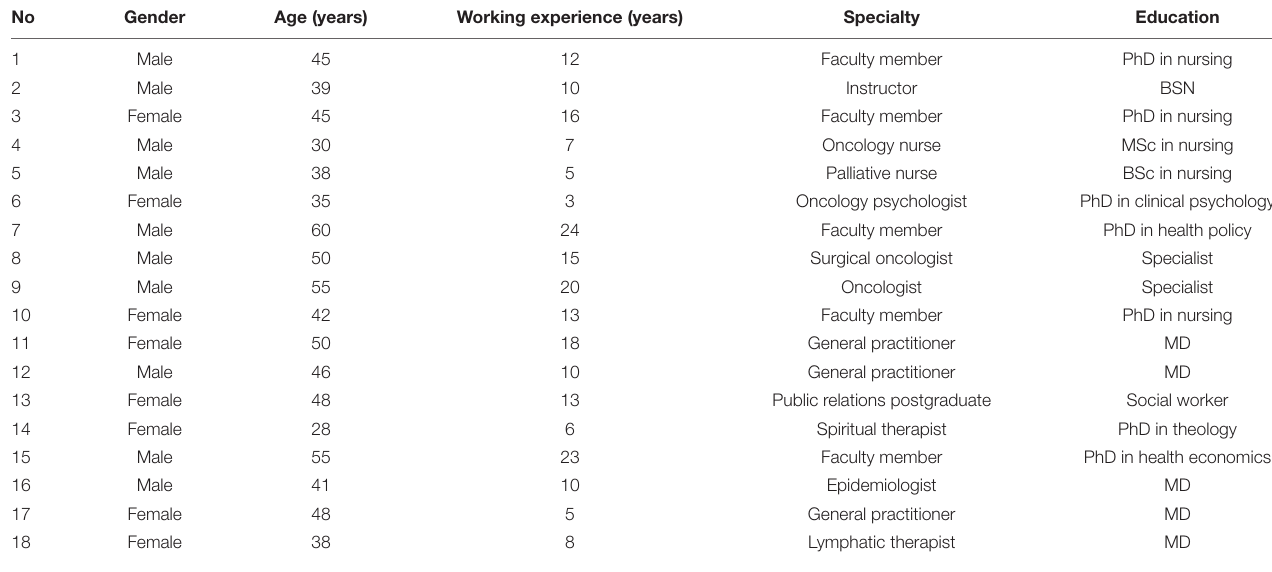
TABLE 1 | The demographic characteristics of participants in Phase